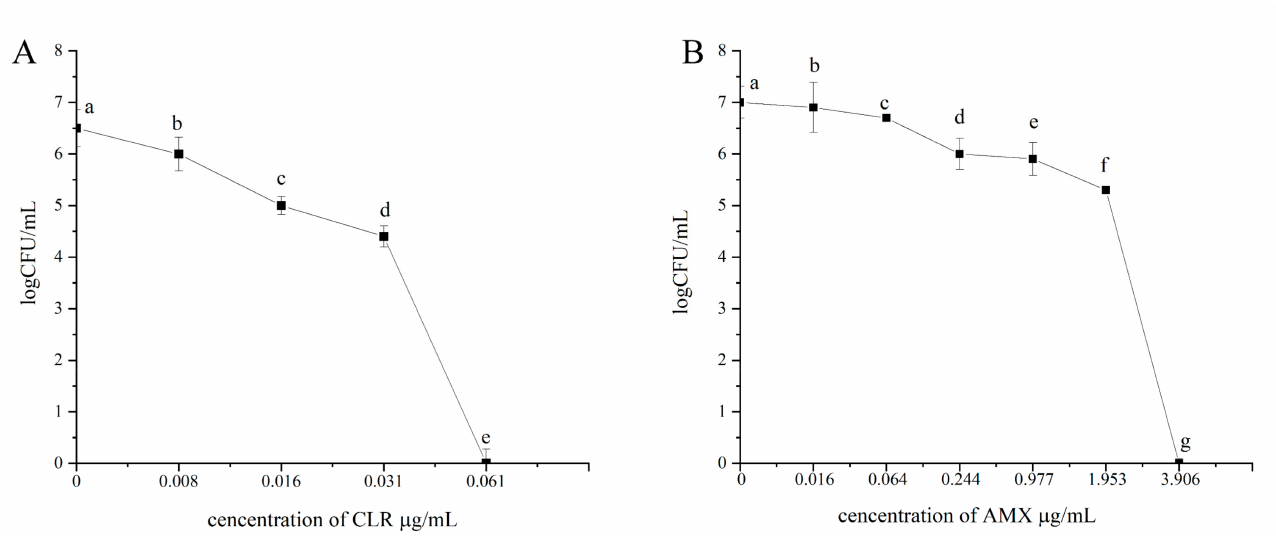
Figure 3. The effects of CLR ( A ) and AMX ( B ) on the cell viability of H. pylori 3192 biofilms. Biofilms of 3192 were exposed to different concentration of CLR and AMX. After exposure to the antibiotics, viable cells from biofilms were measured using CFU counting. All of the results are expressed as the means ± standard deviation from three independent experiments. The groups marked with different superscript letters indicate statistically significant differences ( p < 0.05). AMX: Amoxicillin, CLR: Clarithromycin.